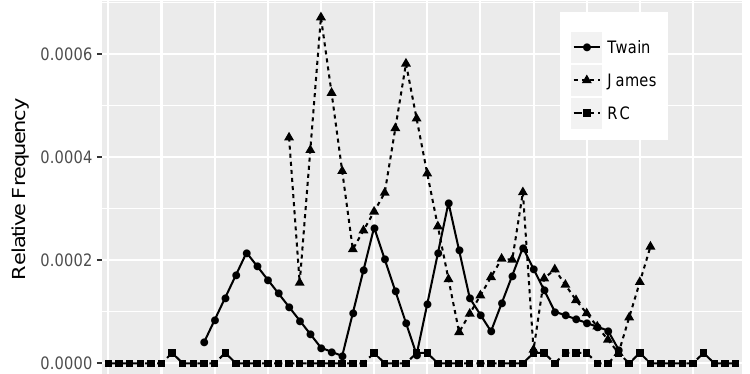
Figure 2: The stem feature h i don t know i for the reference corpus, and for Twain